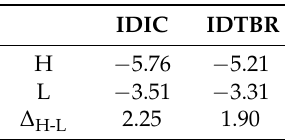
Table 2. Energy levels of HOMO (eV), LUMO (eV) and energy gap ∆ H-L (eV) for Non-fullerene acceptors (NFAs) IDIC,